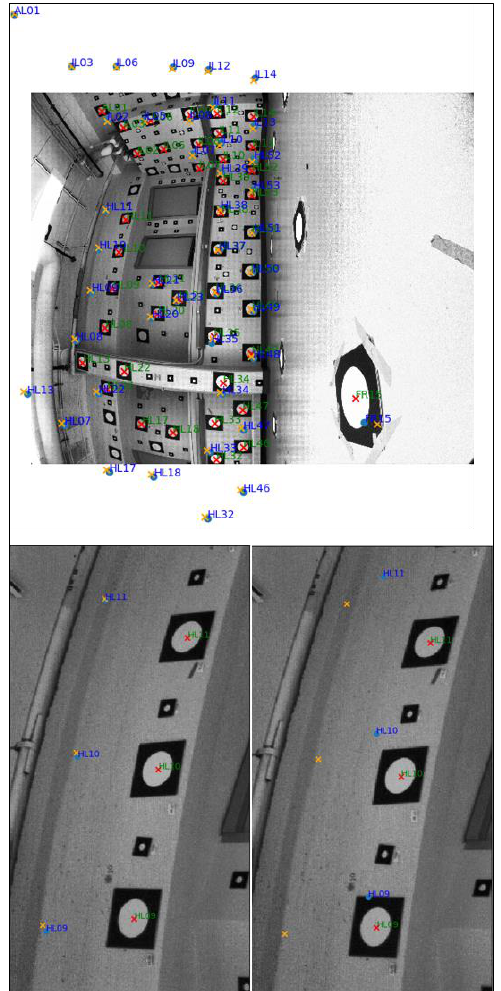
Figure 3. a) Top: Example of matching back-projected targets to rectified target positions. Red x’s are detected target centres. Blue circles are back-projected target centres, orange x’s are rectified detected target centres. Labels are included to show matching back projected targets and their matched target centres. b) Bottom left: close-up of matching results from list entry with the best fitness measure. c) Bottom right: close-up of matching results from list entry with the 10 th best fitness